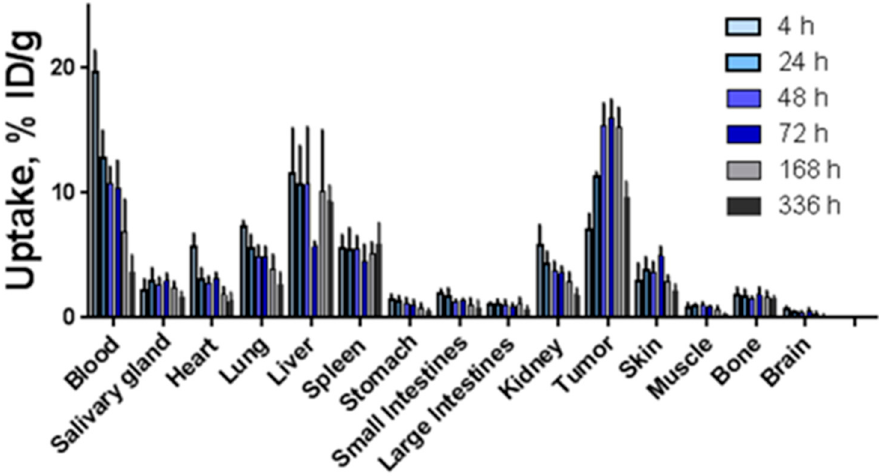
Figure 5. Biodistribution of 177 Lu-DTPA-h5A10 in LnCAP xenografts over time up to 336 h post- injection. The uptake is expressed as % injected dose per gram tissue (%ID/g), and presented as an average ± SD ( n = 4 ). Table 2. Tumor-to-tissue ratios ± SD ( n = 4 per time point ) for 177 Lu-h5A10.